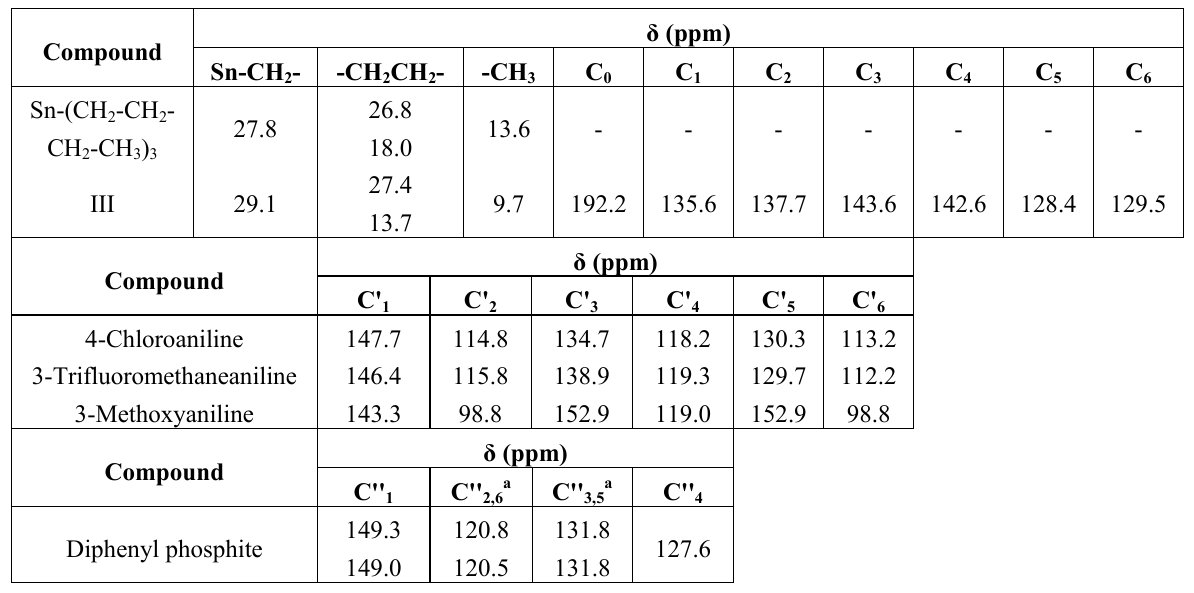
Table 4. 13 C NMR data of the starting